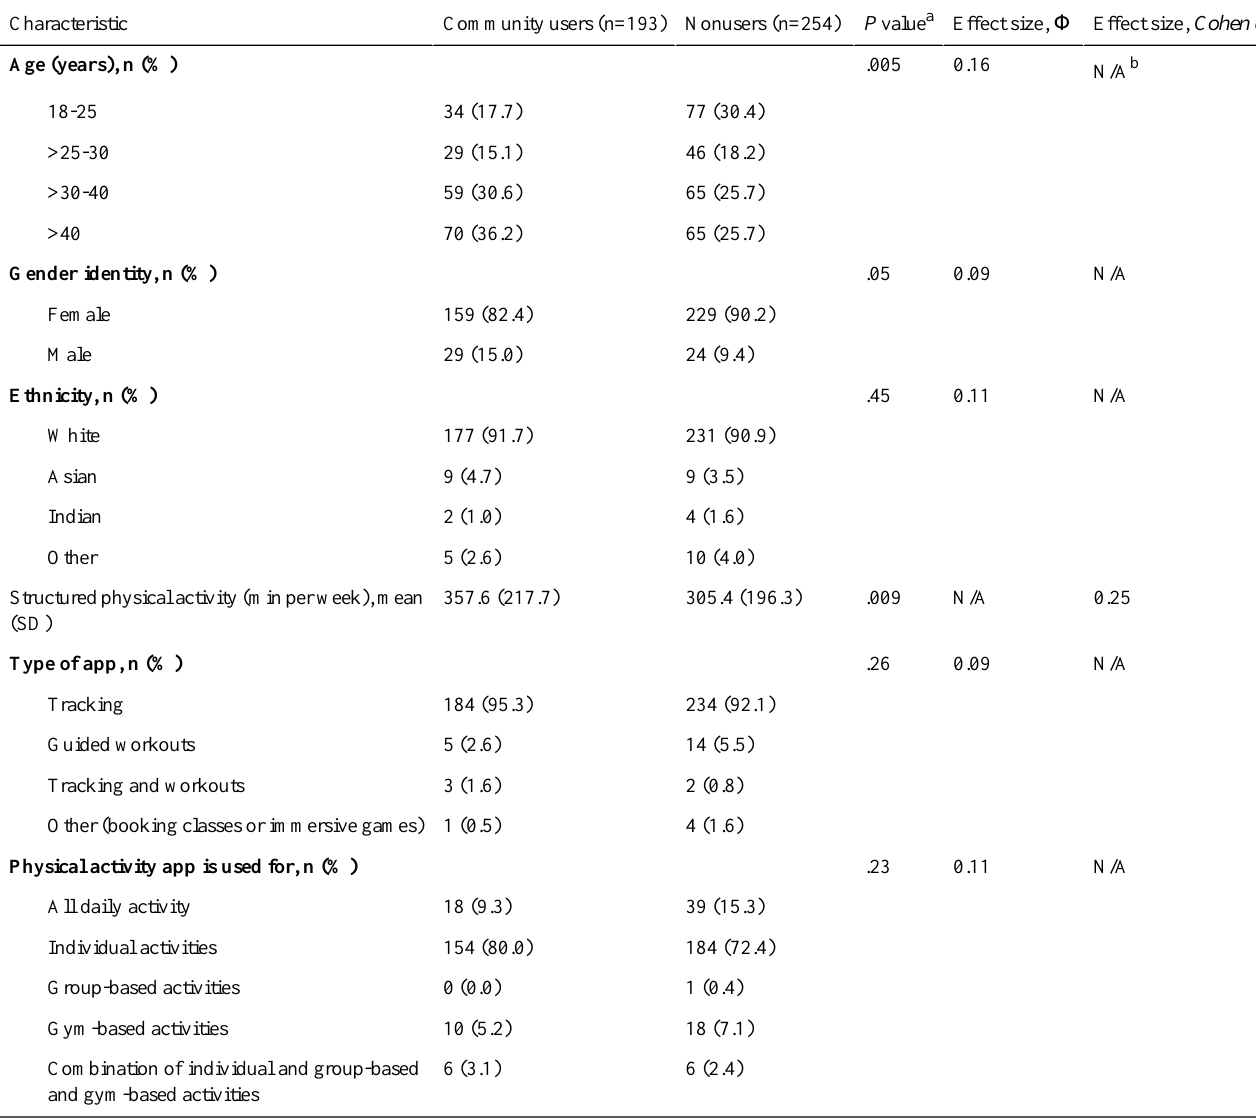
Table 2. Sample characteristics of app-specific community users and nonusers